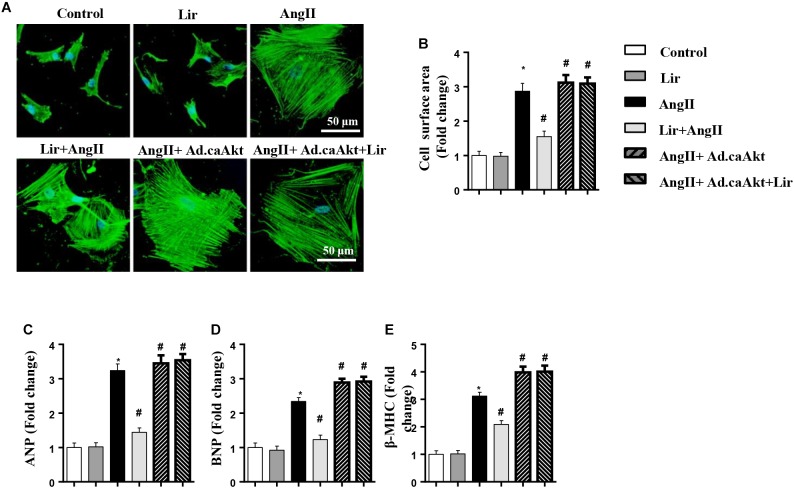
The effect of Lir on human cardiomyocytes. AC16 cells were stimulated with Ang II (1 μM) in the presence of Lir (100 nM) and infected with Ad.caAkt. (A) Representative immunofluorescent staining of α-actin (n = 6). (B) Quantitative analysis of CSA (n > 50 cells per group). (C–E) RT-PCR analysis of the mRNA levels of ANP, BNP, and β-MHC in the indicated groups (n = 6). ∗P < 0.05, compared to the control group; #P < 0.05, compared to the AngII group.